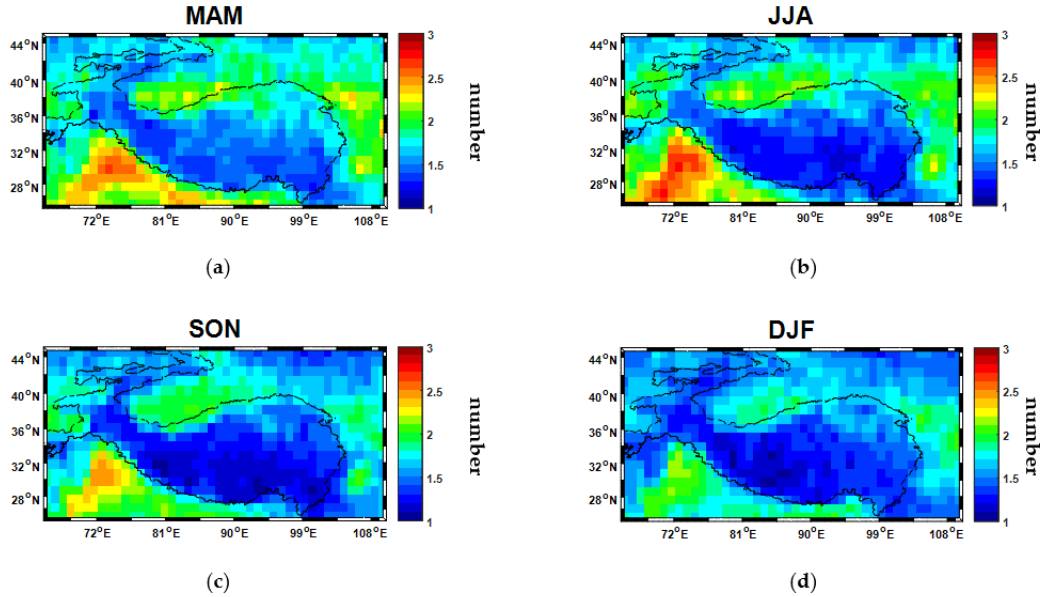
Figure 4. Seasonal maps of the aerosol layer amounts over the TP: ( a ) spring, ( b ) summer, ( c ) fall, and ( d ) winter over the eight-year data period January 2007 to December 2014 (The AOD is at 532 nm and the map is gridded at 1°).